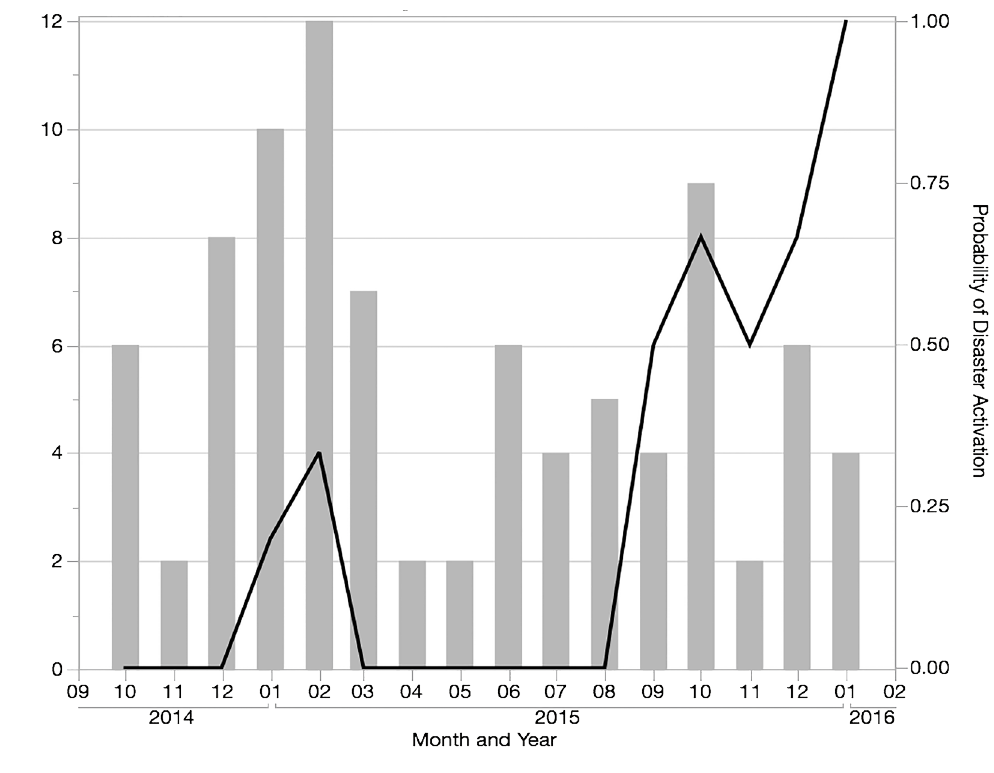
Figure. Code Help trends over